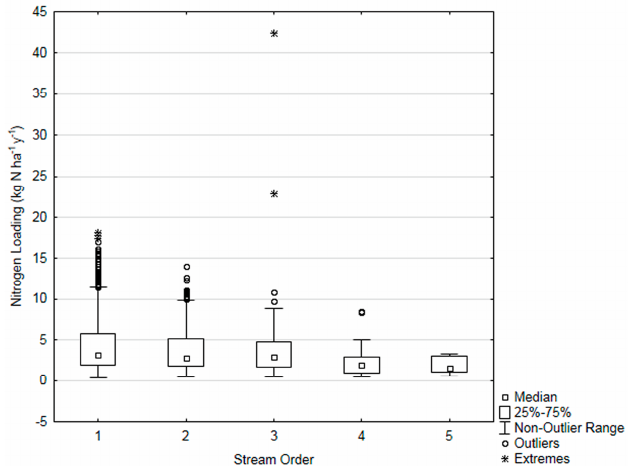
Figure 5. Watershed nitrogen loading from the watersheds of the 2206 N removal dams draining to the Atlantic from New England. Outliers are defined as values >1.5 times the interquartile range. Extremes are defined as values >3 times the interquartile range. Note that two extremes were removed for